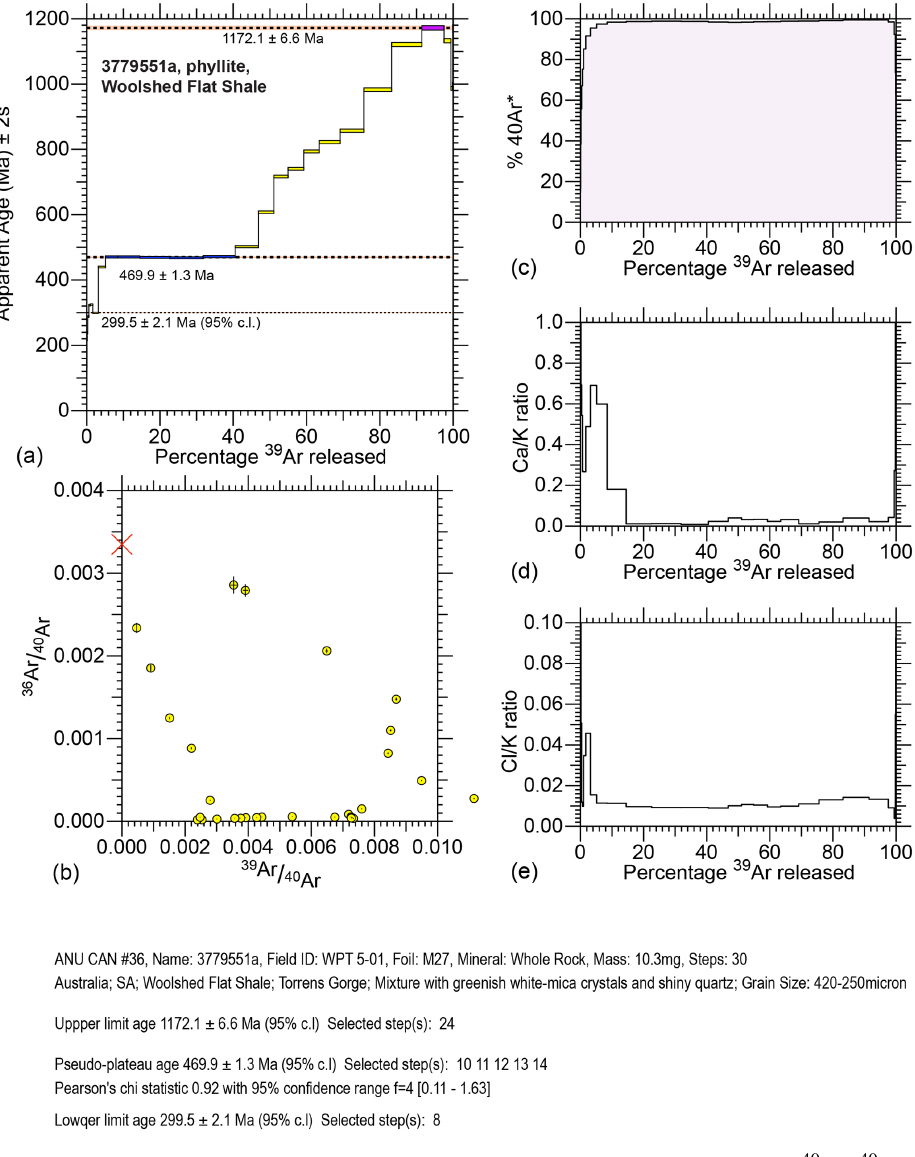
Figure C3. Sample 3779551a (a) age spectrum, (b) isotope correlation diagram, (c) percentage radiogenic 40 Ar ( 40 Ar ∗ ), (d) Ca / K ratio, and (e) Cl / K